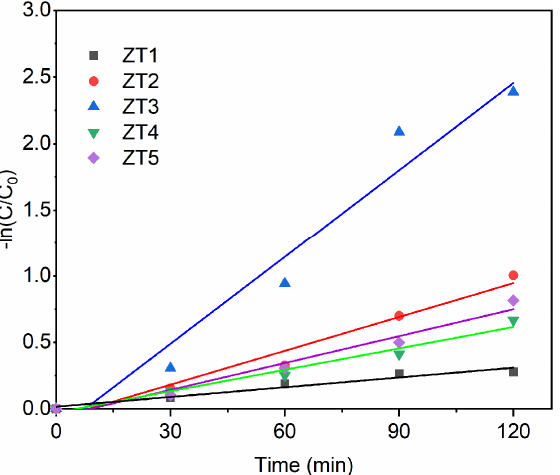
Figure 10. The reaction rate constants of ZT1, ZT2, ZT3, ZT4, and ZT5. Table 2. Comprehensive comparison of the ZT3 with other recent similar photocatalytic films.